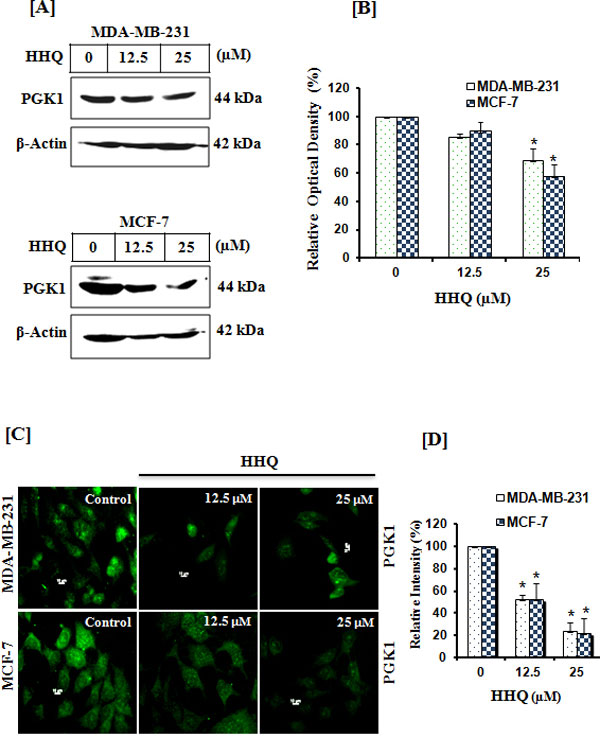
Expression analyses of glycolytic enzyme phosphoglycerate kinase 1 (PGK1) in response to HHQ treatment in human breast cancer cells, MDA-MB-231 and MCF-7. The breast cancer cells were treated with 12.5 μM and 25 μM of HHQ for 48 h at 37 °C. Representative western blot hybridization signals for PGK1 [A] and the quantitation of the signals is shown in [B]. Immunofluorescent detection of PGK1 is shown in [C] and the relative intensity measurement of immunofluorescence is shown in [D]. Significant decrease in PGK1 expression was observed in HHQ treated cells. Data are representative of three independent experiments done in triplicates and expressed as mean ± S.E.M. ''*'' represents the statistical significant (p<0.05) difference between control and HHQ treated groups.